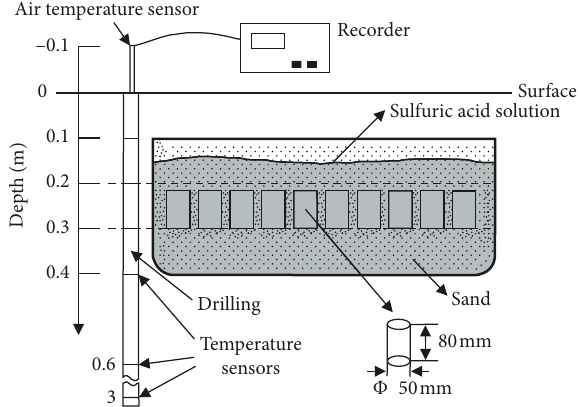
Figure 2: Schematic diagram of field test.